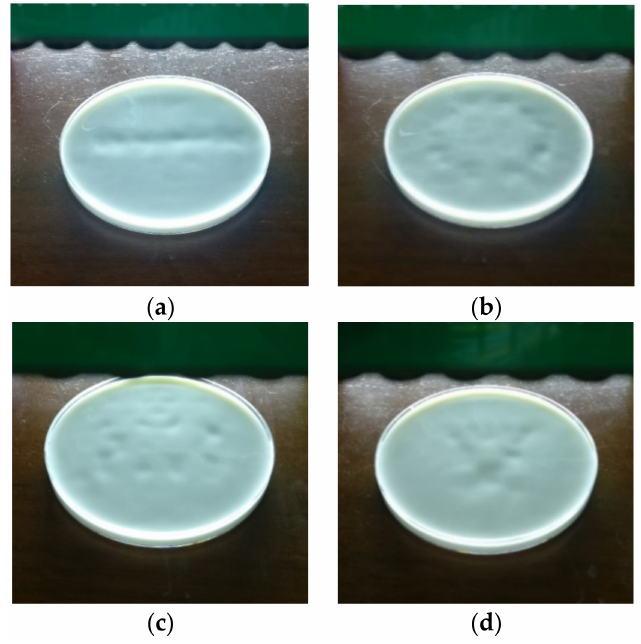
Figure 13. Ultrasound pressure with geometric shapes on liquid surface. ( a ) Line. ( b ) Circle. ( c ) Rectangle. ( d )